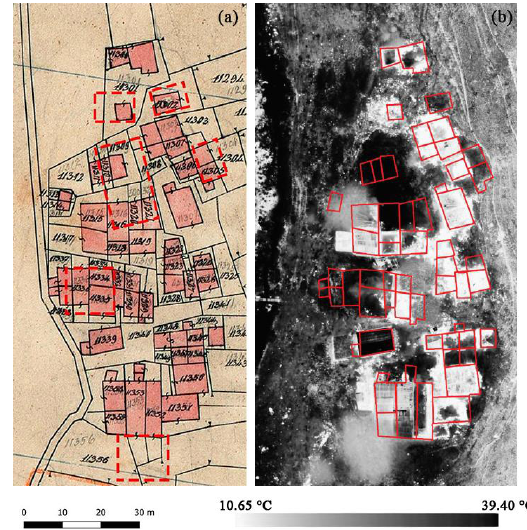
Figure 15. (a) Rabbini Cadastre and the investigated areas (red dashed polygons) detected on the thermal orthomosaic. (b) Overlay between the thermal orthomosaic and the shapes of the buildings (red poligons) reported in Rabbini